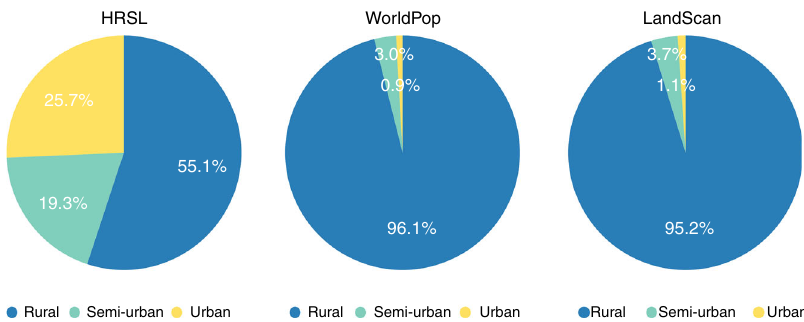
Fig. 5 Proportion of areas returning exposure. Proportion of area returning an exposure value, across rural, semi-urban, and urban areas